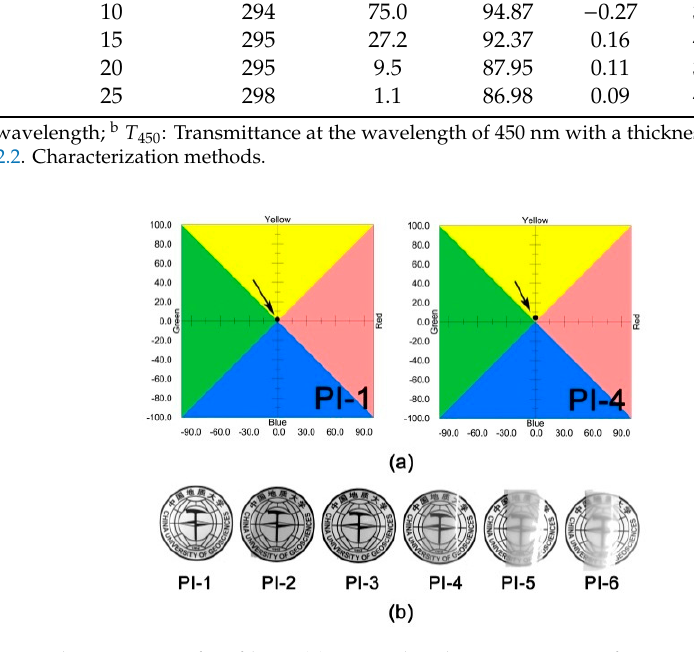
Figure 5. Optical properties of PI films. ( a ) CIE Lab color parameters of PI-1 and PI-4; ( b ) apparent transparency of PI films (thickness: ~50 μ m).